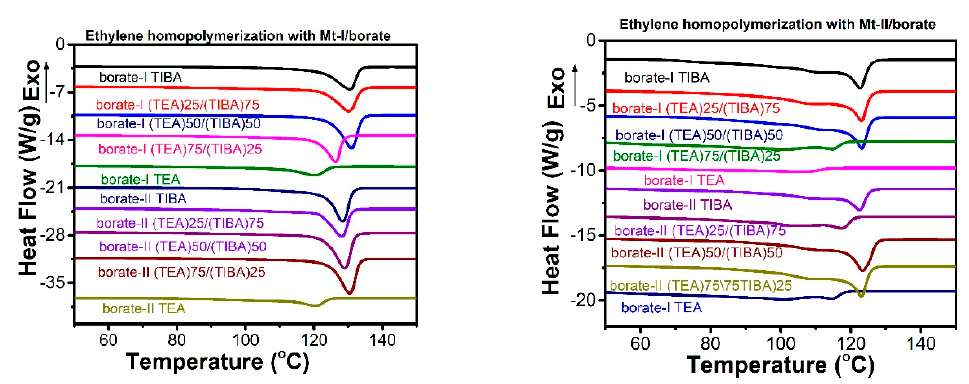
Figure 2. Differential scanning calorimetry (DSC) heating traces of PE produced with both metallocenes under TEA/TIBA mixture of different ratios.